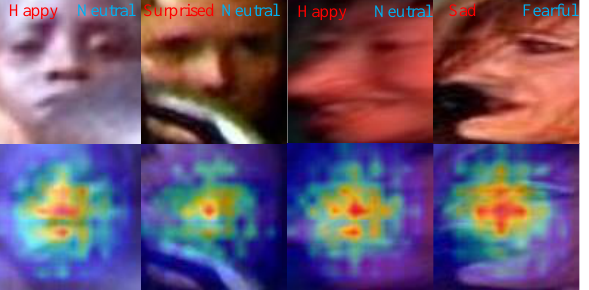
Figure 9. CAMs of some failure cases. The red font is the ground truth, and the blue font is the predicted label. The CAMs exhibit our model’s attention. The lighter colors, the more our model focuses on this